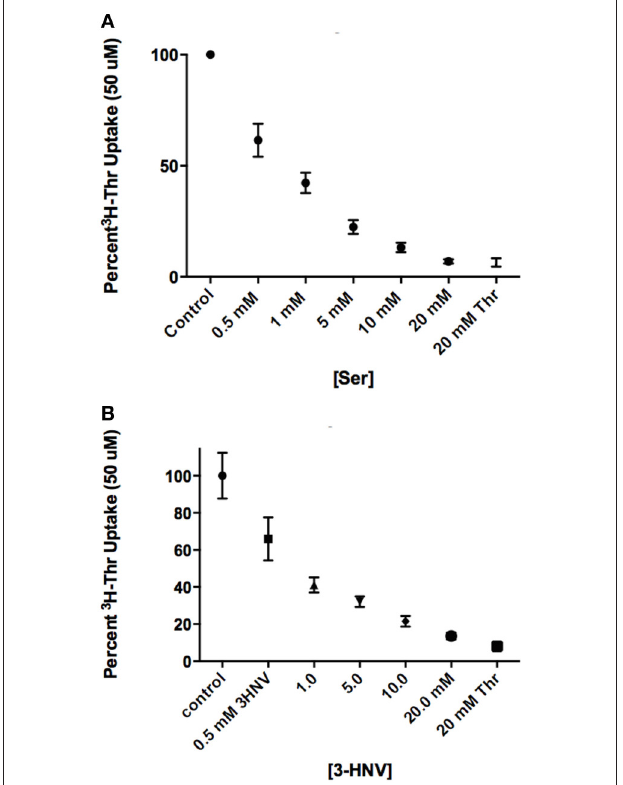
FIGURE 6 | Percent uptake of 50 uM [ 3 H]-Thr in the presence of 140mM NaCl and increasing concentrations of (A) Ser or (B) 3-HNV ( n = 6 for each point; 3 determinations obtained in each of 2 independent experiments). Thr uptake was also measured in the presence of 20mM non-radiolabeled Thr. A 2-sample t -test indicated that [ 3 H]-Thr uptake in 20mM Ser was not significantly different from [ 3 H]-Thr uptake in 20mM non-radiolabeled Thr ( p > 0.05 ), whereas [ 3 H]- Thr uptake in 20mM 3-HNV was significantly higher than [ 3 H]- Thr uptake in 20mM non-radiolabeled Thr ( p < 0.05 ). A one-way ANOVA also indicated that 50 uM [ 3 H]-Thr uptake significantly decreased with increasing concentration of Ser or 3-HNV ( p < 0.05 ).